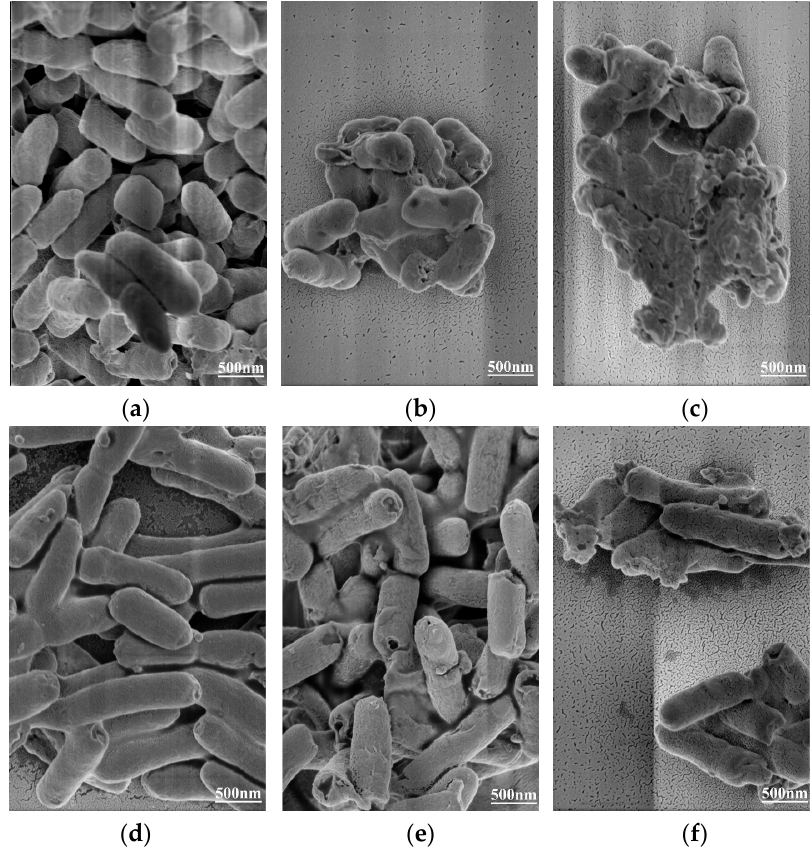
Figure 6. Effect of CA on cell morphology of Y. enterocolitica and E. sakazakii . ( a ) Untreated Y. enterocolitica, ( b ) Y. enterocolitica treated with MIC CA, ( c ) Y. enterocolitica treated with 2 MIC CA, ( d ) untreated E. sakazakii , ( e ) E. sakazakii treated with MIC CA, and ( f ) E. sakazakii treated with 2 MIC CA. 2.8. Inhibitory Effect of CA on Y. enterocolitica in Raw Pork and E. sakazakii in Skim Milk Gram-negative bacteria Y. enterocolitica and E. sakazakii are common pathogens,